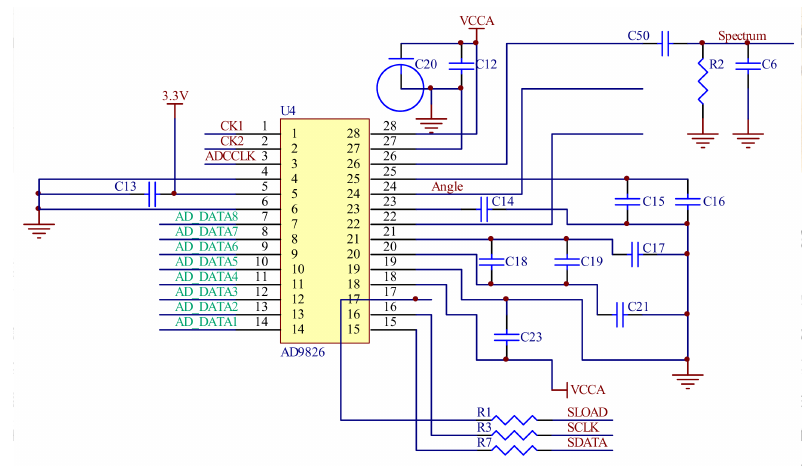
Figure 11. The analog-digital conversion (ADC) circuit of the signal detecting